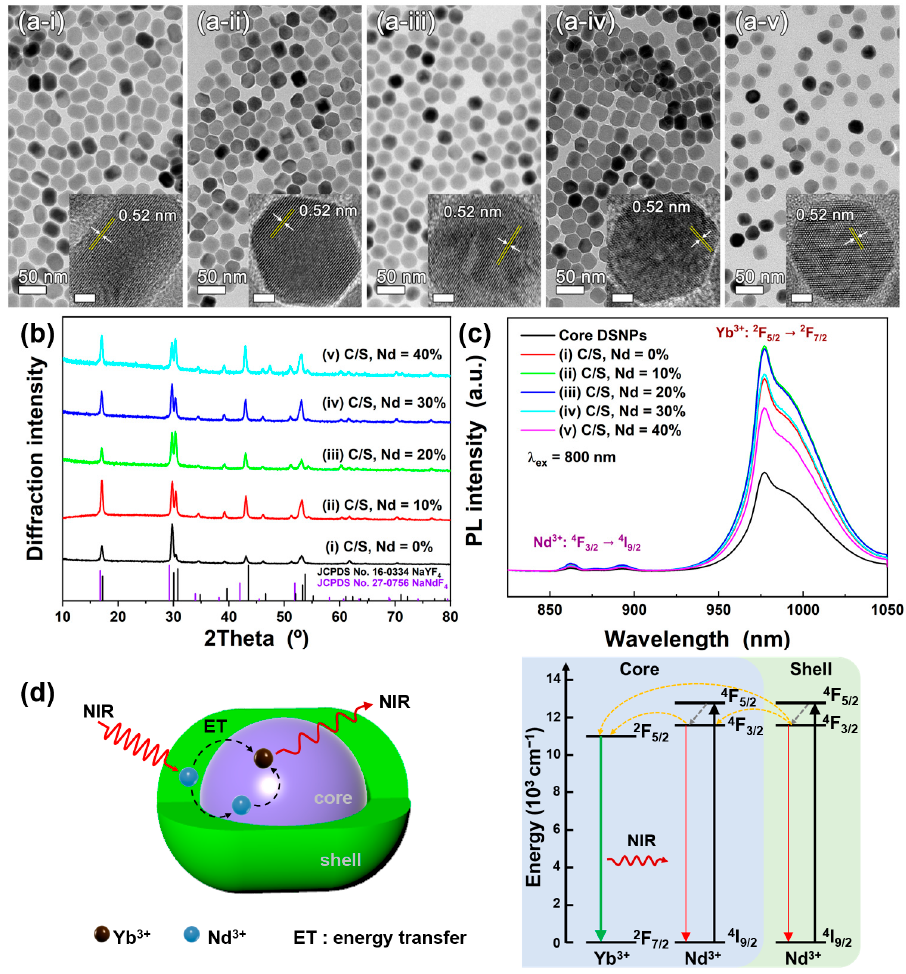
Figure 4. ( a ) TEM and HR-TEM images, ( b ) XRD patterns, and ( c ) PL spectra of NaYF 4 :Nd (30%),Yb (10%)/NaYF 4 :Nd (x%) C/S DSNPs with various Nd 3+ concentrations [x = ( i ) 0%, ( ii ) 10%, ( iii ) 20%, ( iv ) 30%, and ( v ) 40%]. ( d ) Schematic illustration showing the core/shell structure of the NaYF 4 :Nd,Yb/NaYF 4 :Nd DSNP (left) and schematic energy level diagram showing the energy transfer from Nd 3+ to Yb 3+ in the C/S DSNPs (right). Scale bars in the insets of ( a ) indicate 5 nm.